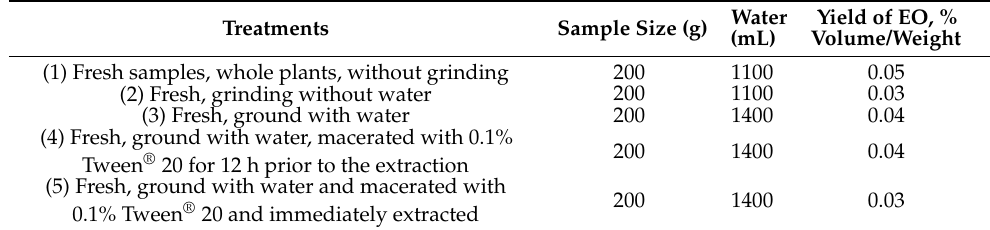
Table 6. Results from the second experiment; treatments, samples size (g), and oil yield (%) of Marrubium friwaldskyanum in